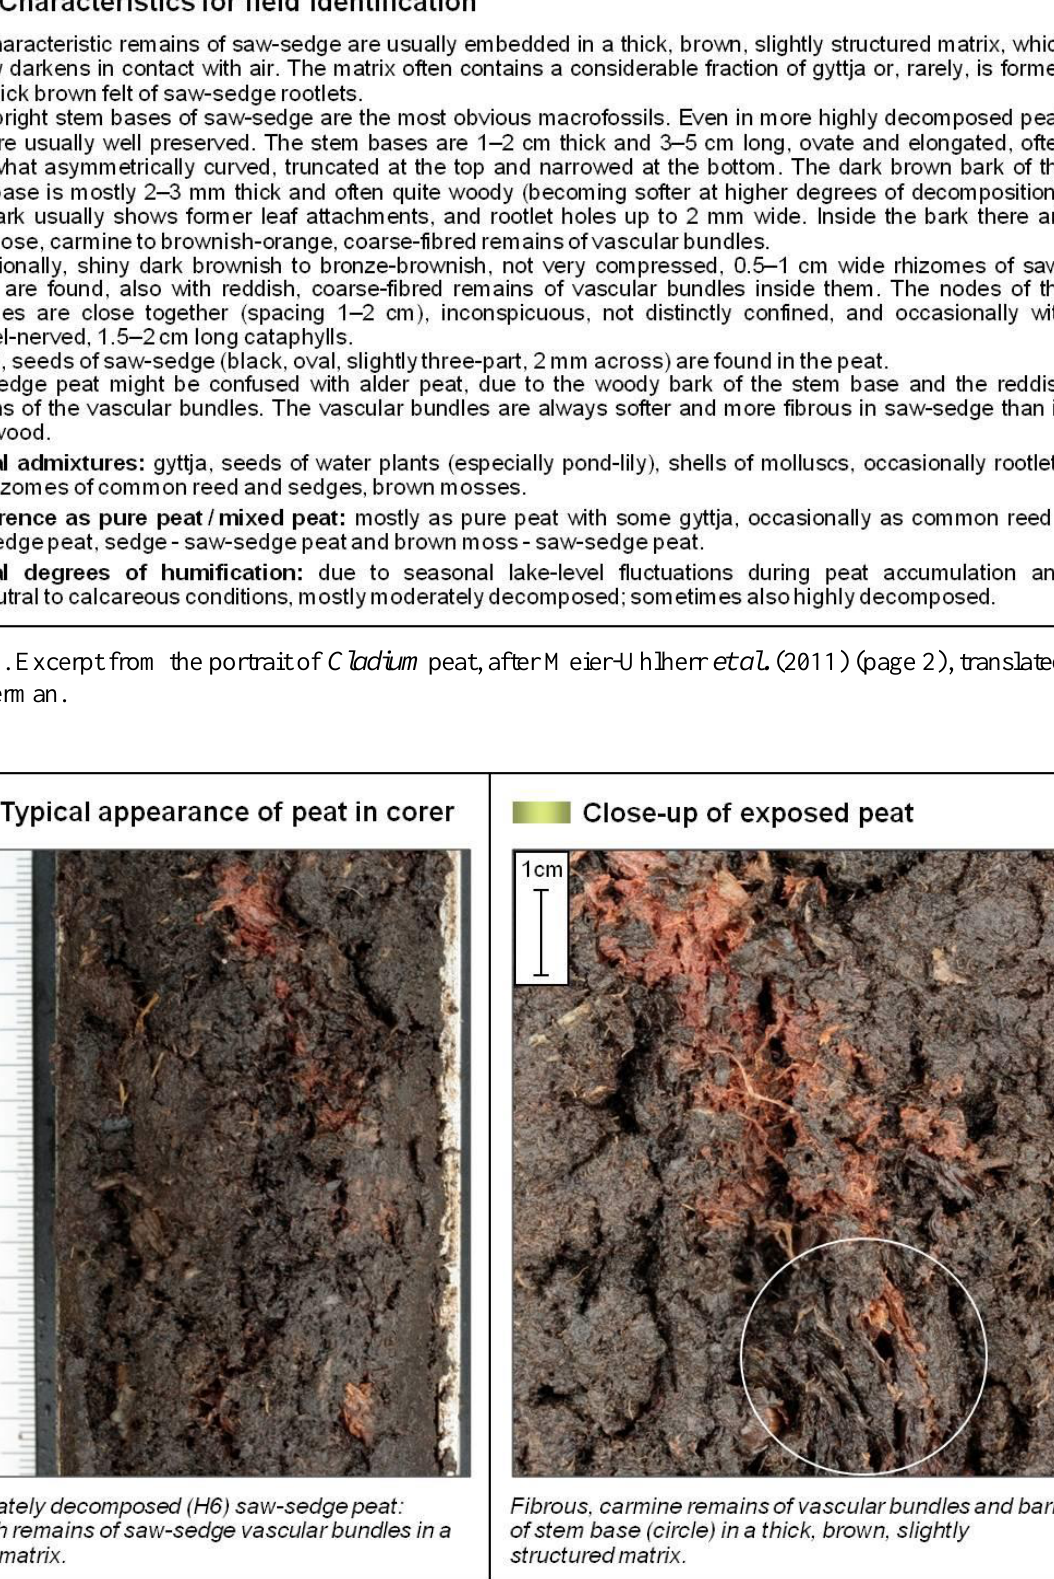
Figure 2. Excerpt from the portrait of Cladium peat, after Meier-Uhlherr et al. (2011) (page 3), translated from